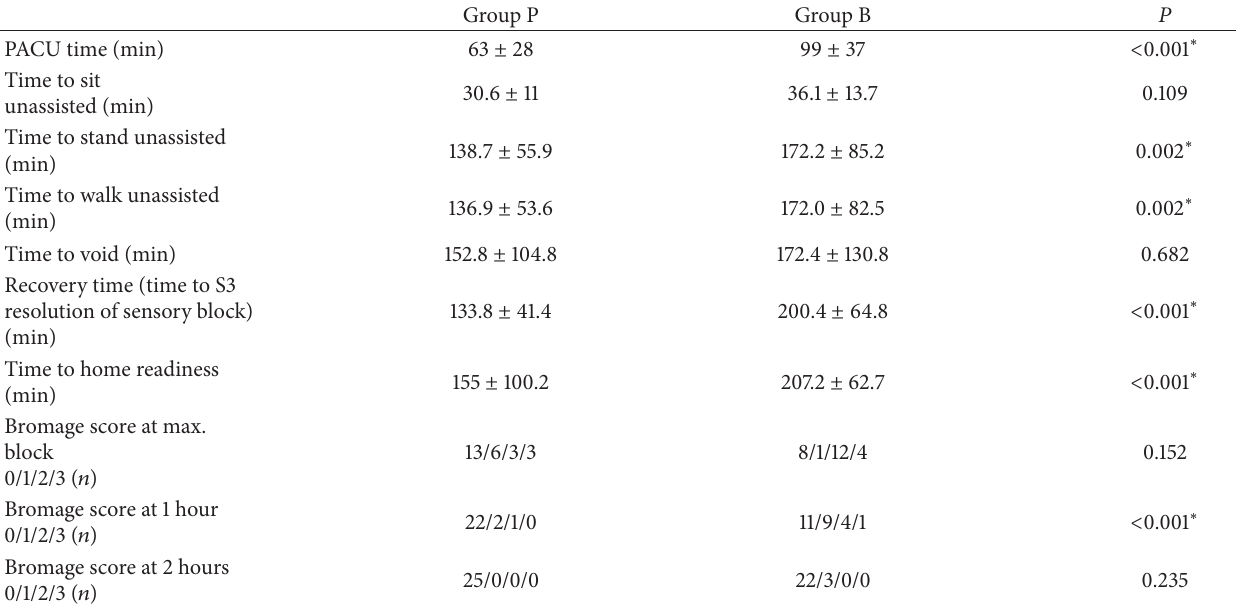
Table 2: Recovery and motor block characteristics.